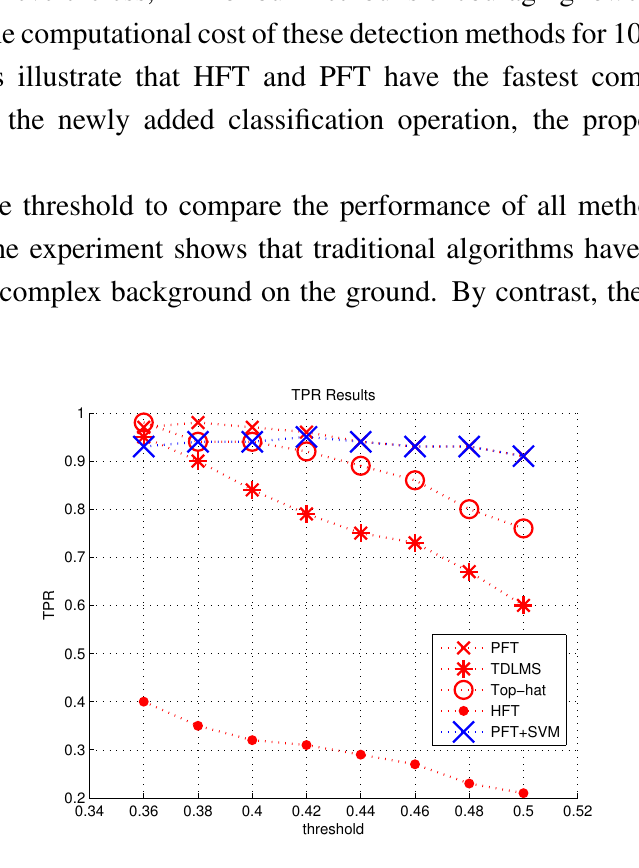
Figure 8. True positive rate (TPR) of all